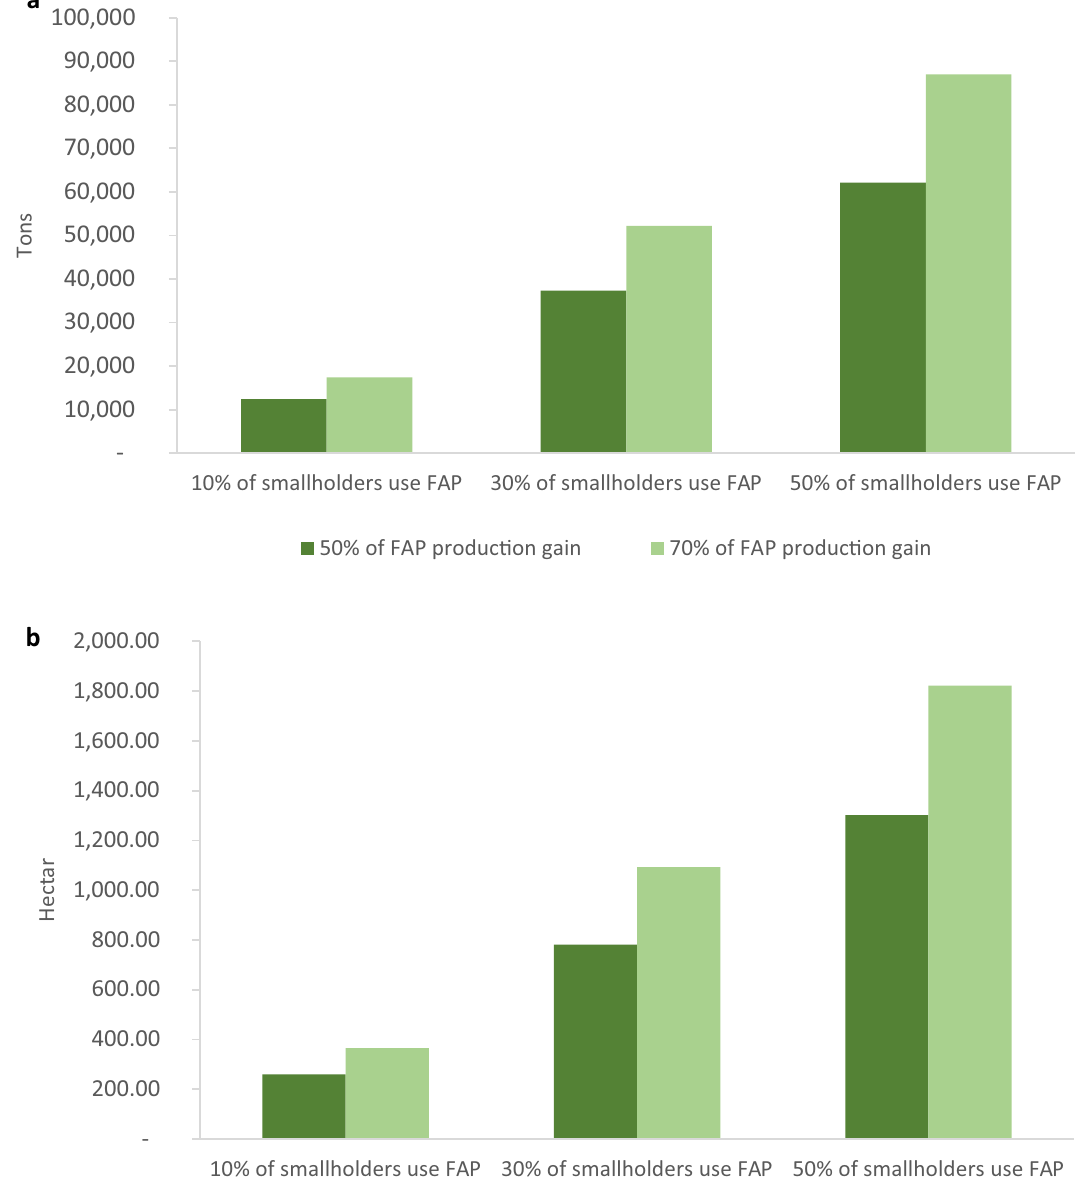
Figure 3. Simulation of potential impacts of Farming-Alternative Pollinators on food security and saving land for nature through smallholders based on 6 vegetables and Moroccan production data 2016–2017; ( a ) simulated potential increase of production; ( b ) simulated potential for land